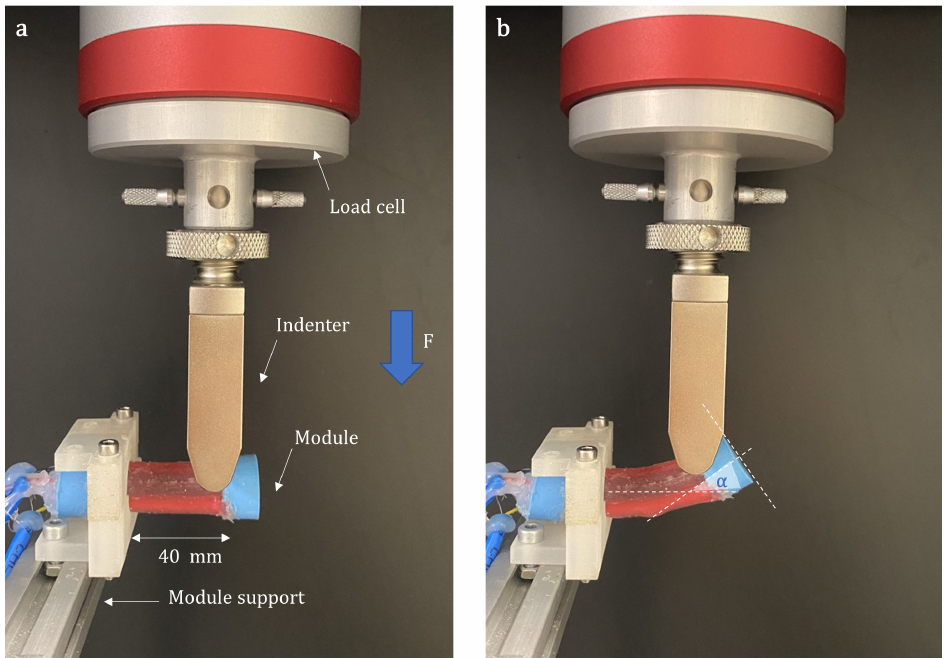
Figure 5. Setup for testing variable stiffness ( a ) at rest position and ( b ) in a bent configuration showing the bending angle. (Module FJ is reported as an